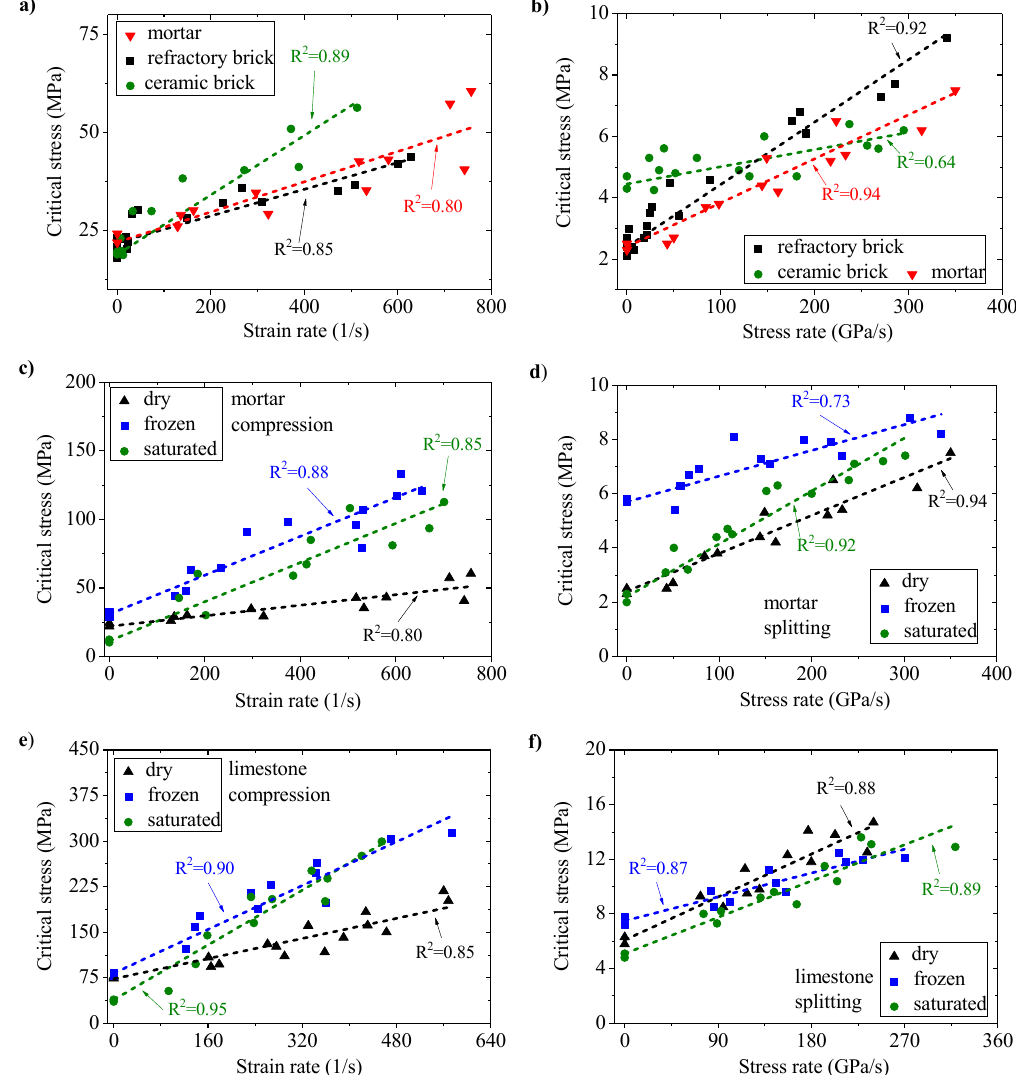
Figure 3. Comparison of the critical stress dependencies on a strain rate in compression ( a , c , e ) and splitting ( b , d , f ) tests of cylindrical specimens of quasi-brittle constructional materials. ( a , b ) Different materials; ( c , d ) different states of mortar; ( e , f ) different states of limestone. R 2 is the coefficients of determination.